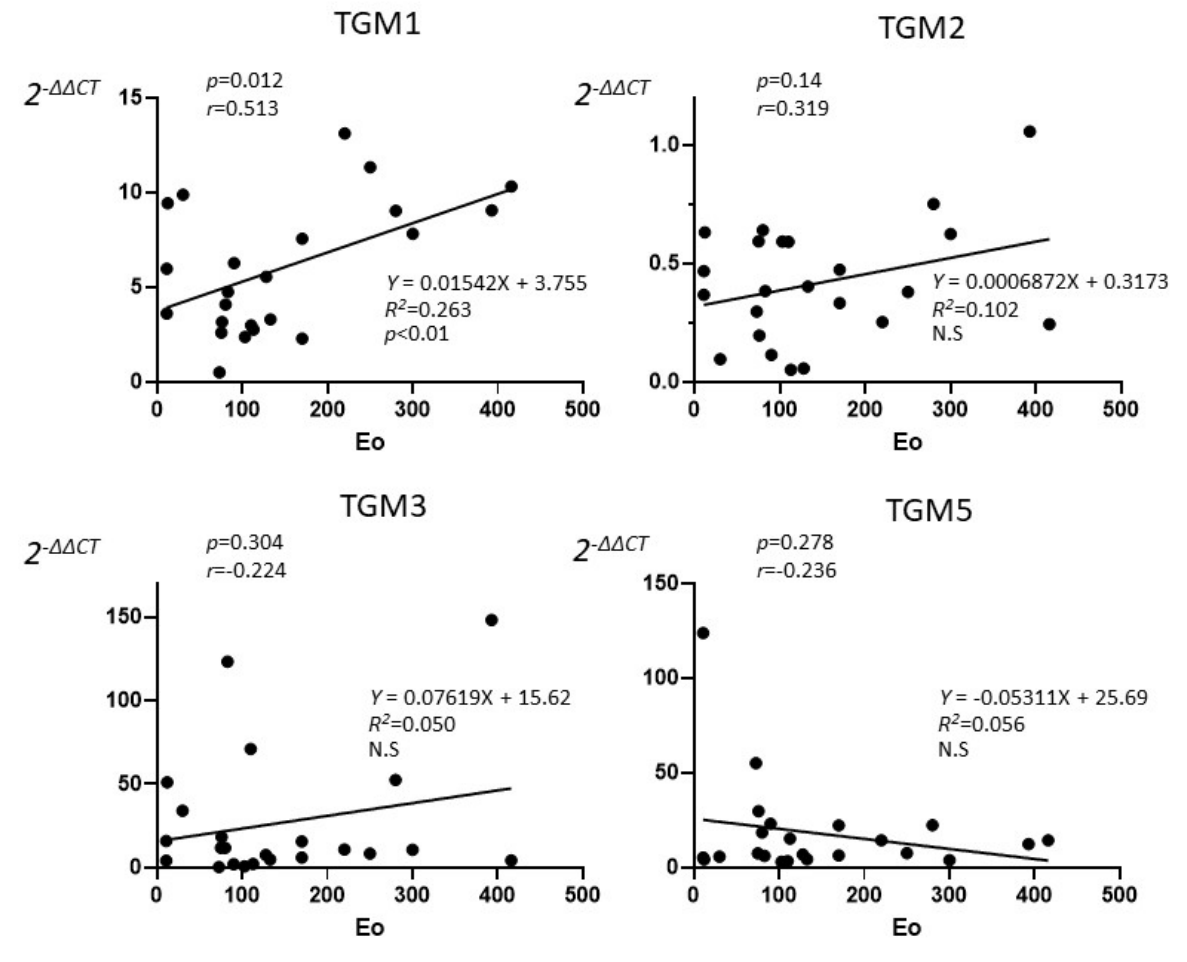
Figure 2. The correlation between the tissue eosinophils counts and the expression of TGM 1, 2, 3, and 5 in the CRSwNP patients who performed tissue eosinophil counts in NP ( n = 23). Pearson’s correlation coefficient showed only a significant correlation between TGM 1 and tissue eosinophil with high degree ( p = 0.012, r = 0.513), but TGM 2 ( p = 0.138, r = 0.319), TGM 3 ( p = 0.304, r = 0.224), TGM 5 ( p = 0.278, r = − 0.236) did not show significance. Each line showed linear regression. From linear regression analysis, only TGM 1 expression was predicted by the eosinophil count ( R 2 = 0.263, p <